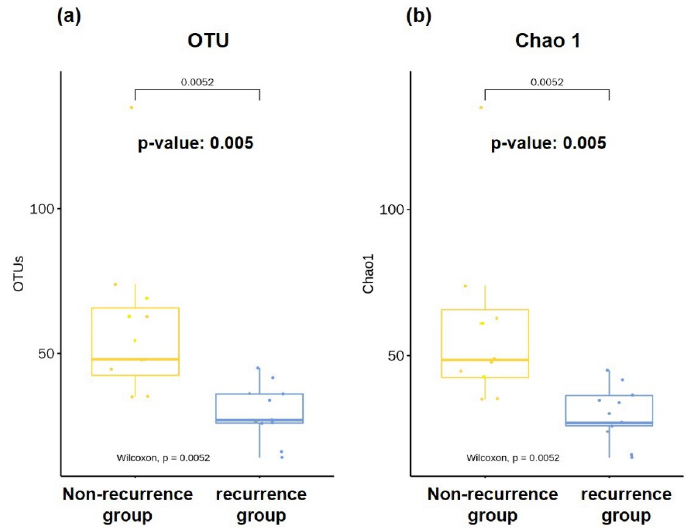
Figure 1. Comparison on richness of microbiota in bile. Microbiota richness, represented as the number of ( a ) observed operational taxonomic units (OTU) and ( b ) Chao 1, was reduced in the recurrent CBD stone group ( n = 11) compared with the non-recurrence group ( n = 9).